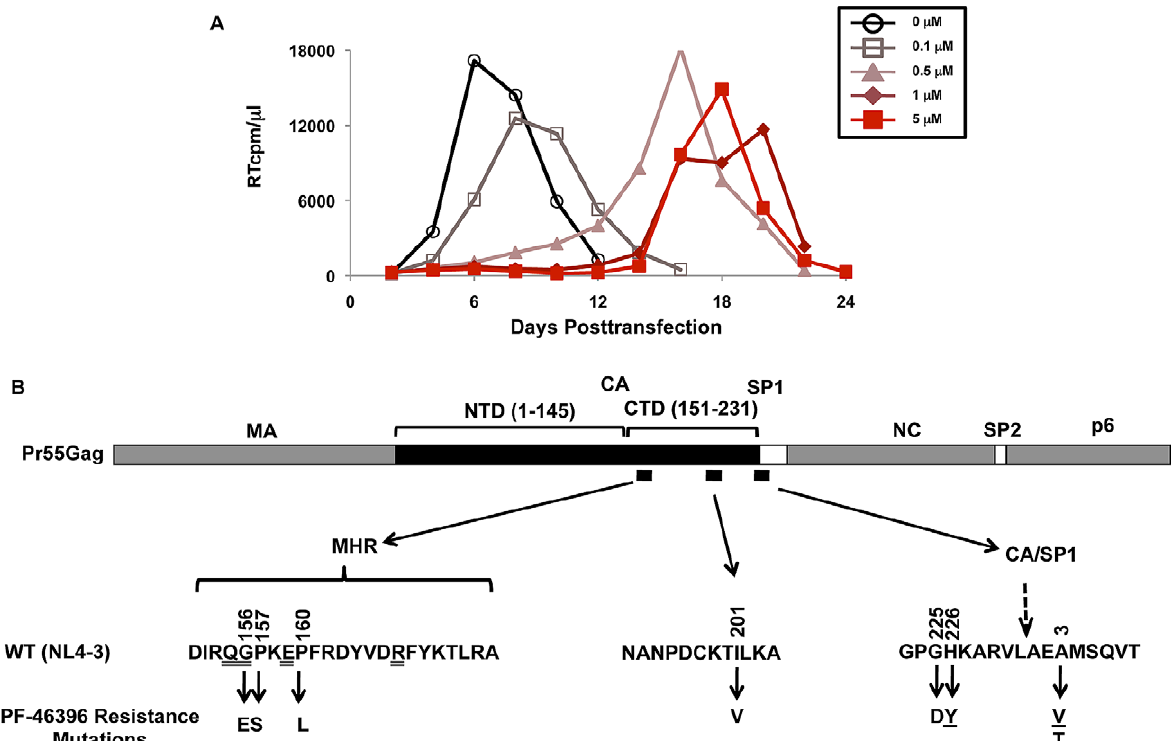
Figure 4. PF-46396 resistance mutations map to three regions within the CA-CTD and SP1. [A] Example of a selection experiment for PF- 46396 resistance. The Jurkat T-cell line was transfected with pNL4-3 and propagated in the presence of 0–5 m M PF-46396. Virus replication was monitored by RT activity, shown in counts per minute (cpm) per m l of culture medium. [B] Location of PF-46396 resistance mutations in Gag. A linear diagram of Pr55 Gag is provided, with CA N-terminal and C-terminal domains (NTD and CTD, respectively) indicated. Small black boxes denote the location in Gag of the resistance mutations, which are shown below using CA and SP1 amino acid numbers. Single-underlined mutations represent those that we previously obtained during BVM selections; highly conserved residues in the MHR are denoted by double